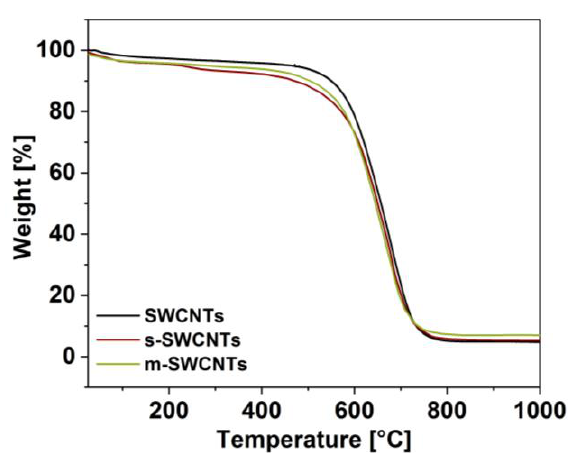
Figure 6. Thermograms of separated and purified s-SWCNTs and m-SWCNTs. Raw SWCNT material is given as a reference.